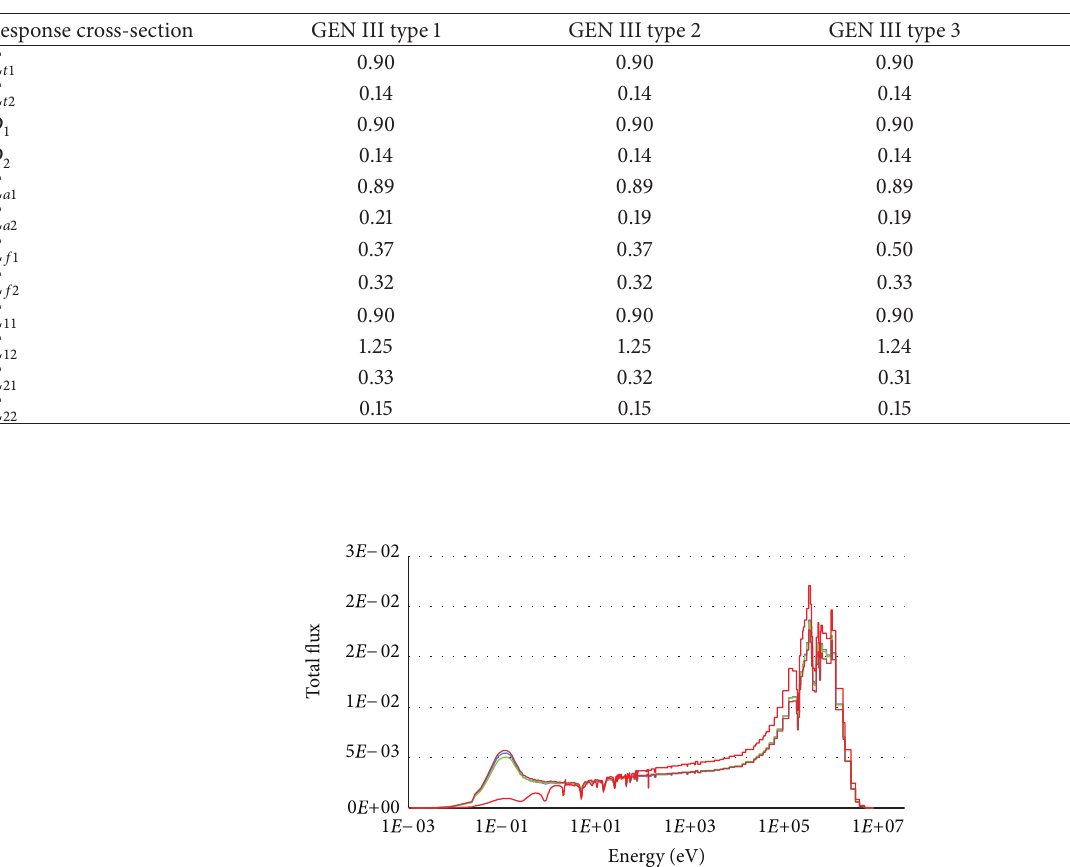
Table 8: Two-group cross-section uncertainty (% Δ𝑅/𝑅 ) in GEN-III fuel assembly.